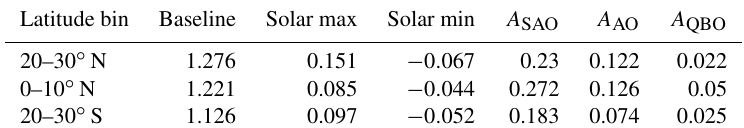
Table 2. Summary of multiple linear regression analysis results of monthly mean atomic oxygen column densities integrated over 80–97km denote the fitted atomic oxygen column densities solely from the solar cycle component, under the solar minimum and solar maximum conditions, respectively. A SAO , A AO and A QBO are the amplitudes of SAO, AO and QBO, respectively.